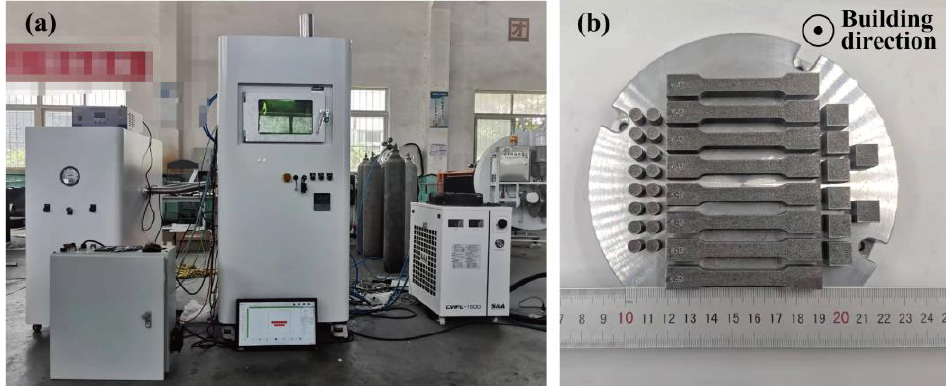
Figure 3. ( a ) The photograph of SLM printer, ( b ) the samples printed on AlSi10Mg substrate. Table 2. The optimized SLM parameter combinations.